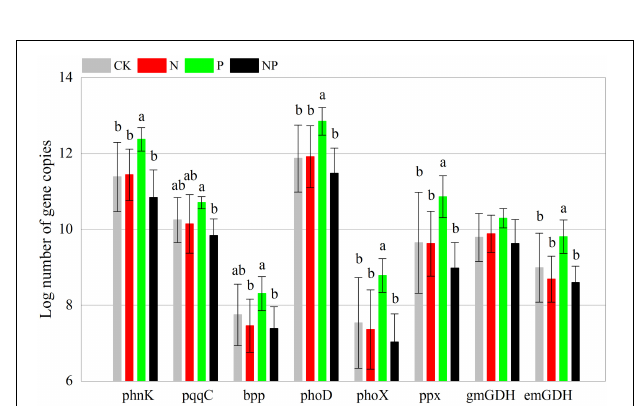
FIGURE 3 | Abundance of N cycling functional genes among experimental treatments. Different letters indicate significant differences at a p < 0.05 level across experimental treatments. No letter indicates a non-significant difference (CK = control, N = addition of 72 kg N hm − 2 year − 1 , P = addition of 36 kg P hm − 2 year − 1 , NP = interaction of N and P).